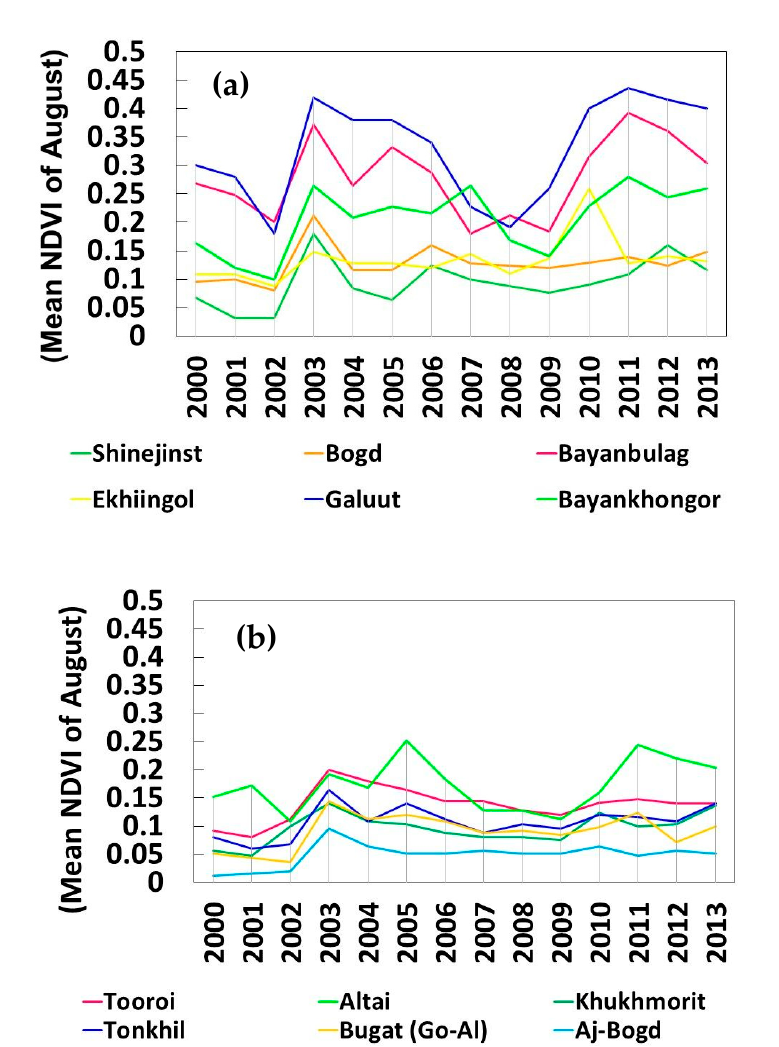
Figure 4. Trends of mean NDVI of August for the period from 2000 to 2013 at meteorological stations in ( a ) Bayankhongor province; ( b ) Gobi-Altai provinc.